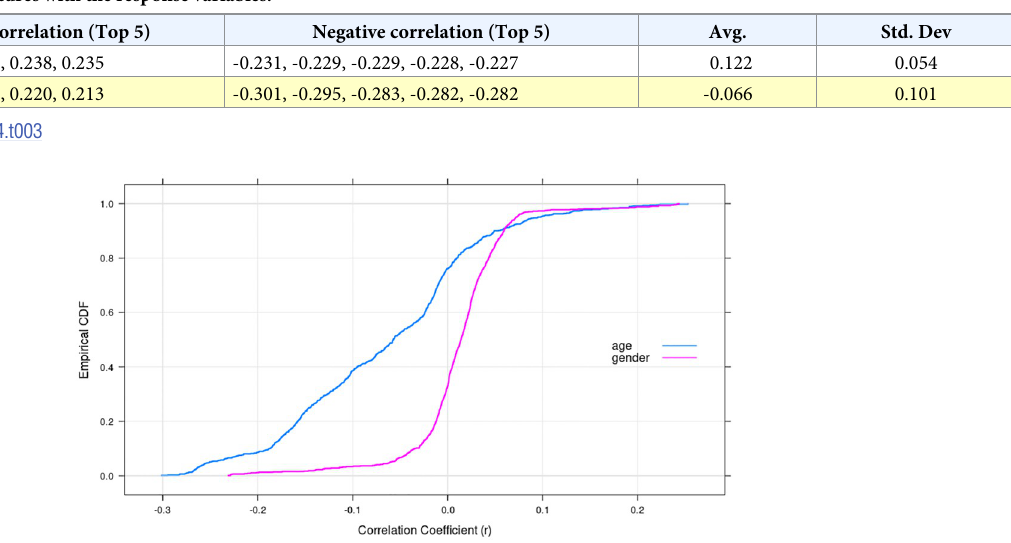
Table 3. Correlation of surviving 749 features with the response variables.